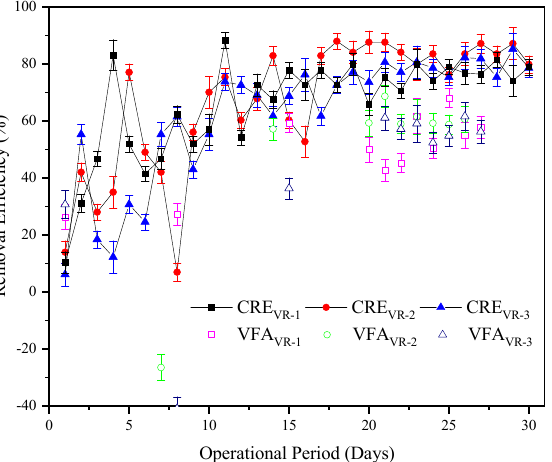
Figure 6. The performance of optimized runs for COD, TC and VFA removal.